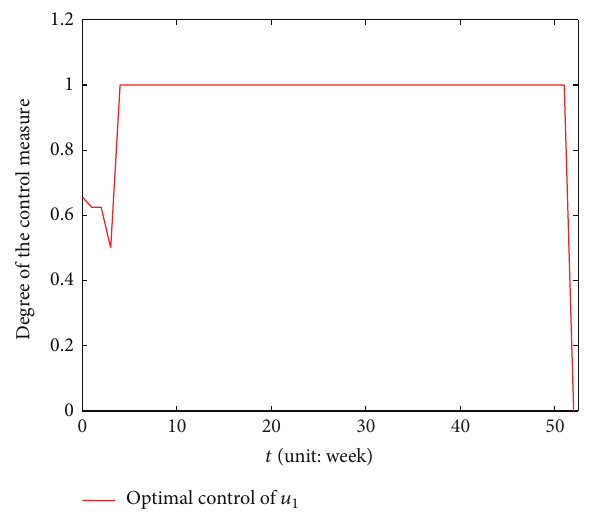
Figure 9: Figures of the optimal control 𝑢 1 when we choose the weight in objective function are 𝑐 1 = 10 2 ; 𝑐 2 = 10 4 .